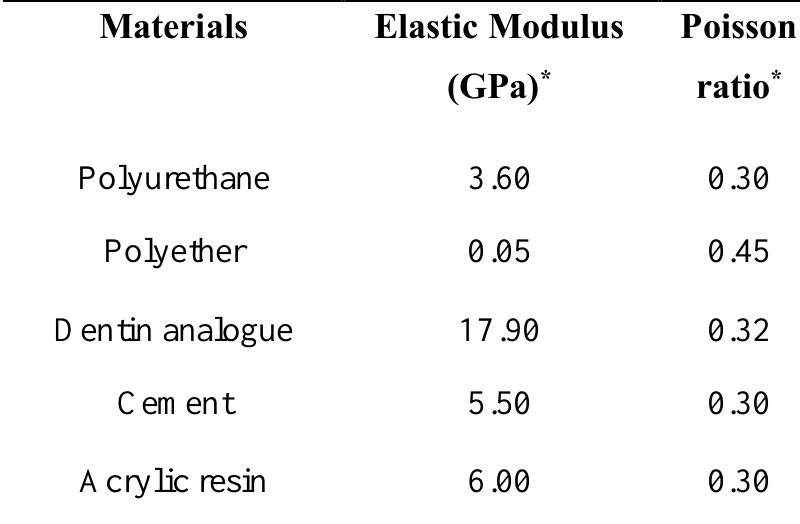
*Characterization done by an acoustic excitation